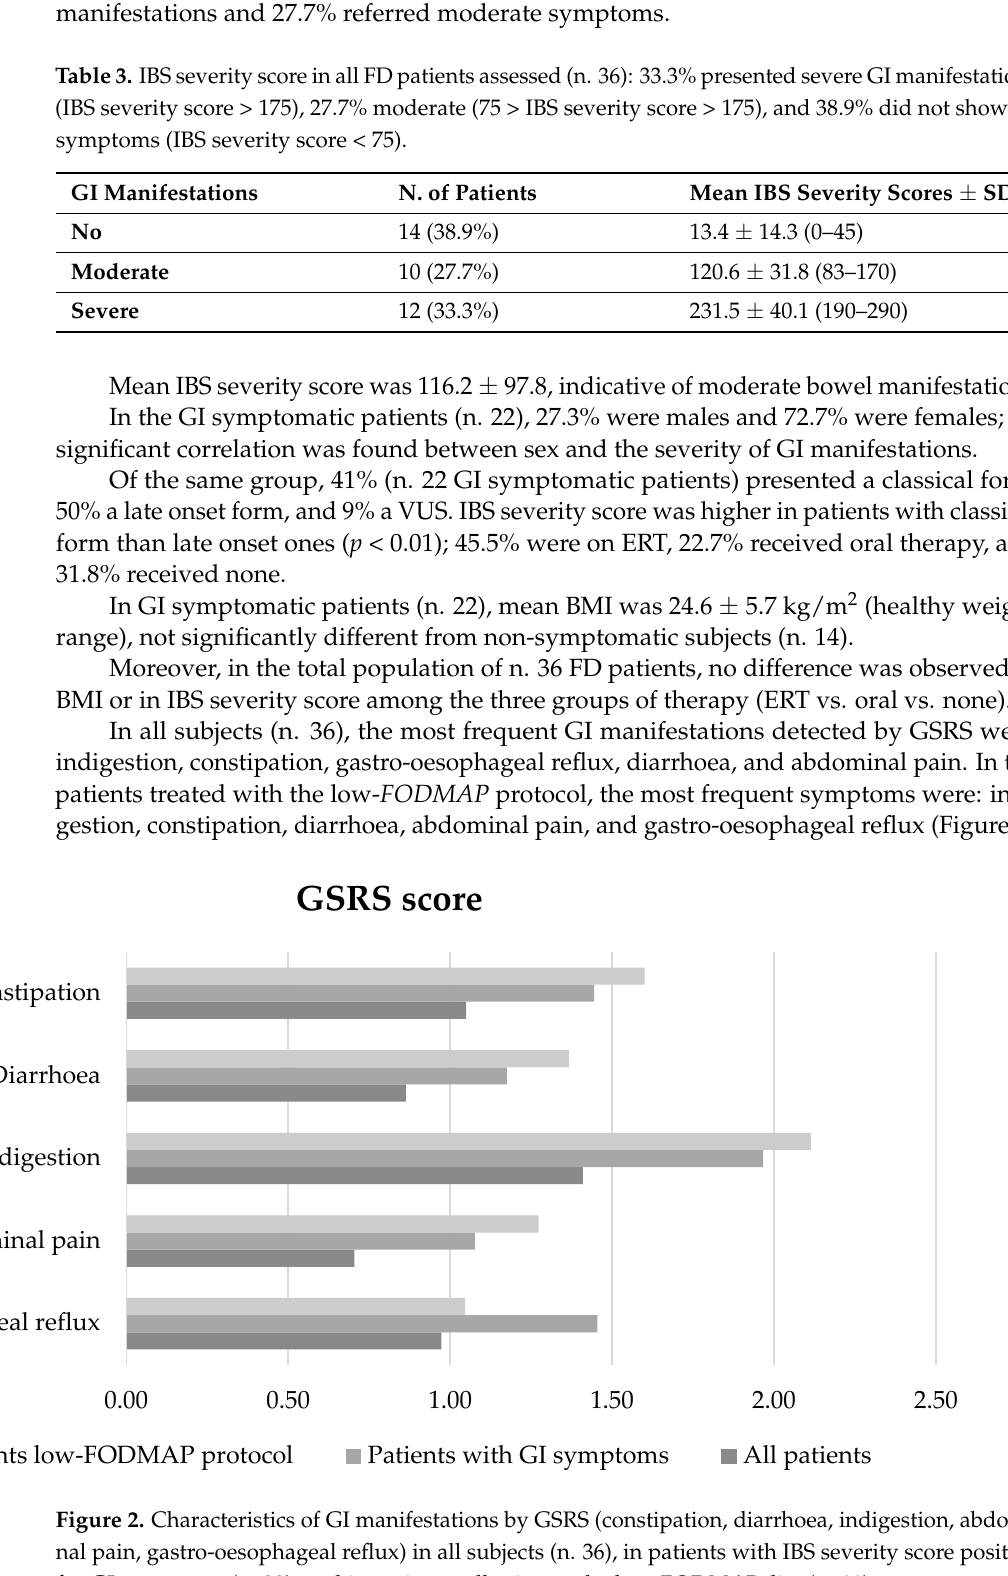
Figure 2. Characteristics of GI manifestations by GSRS (constipation, diarrhoea, indigestion, abdominal pain, gastro-oesophageal reflux) in all subjects (n. 36), in patients with IBS severity score positive for GI symptoms (n. 22), and in patients adhering to the low-FODMAP diet (n. 11).